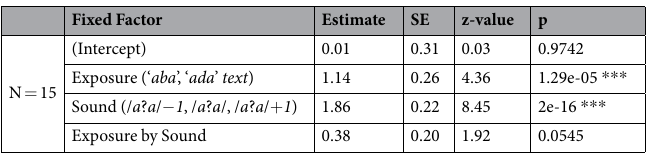
Table 2. Behavioural results in the scanner. Fitted model: Response ~1 + Exposure * Sound + (1 + Exposure + Sound || Subject). Fixed effects correlations were below 0.06. SE = standard error *** p < 0.001; ** p < 0.01; * p <